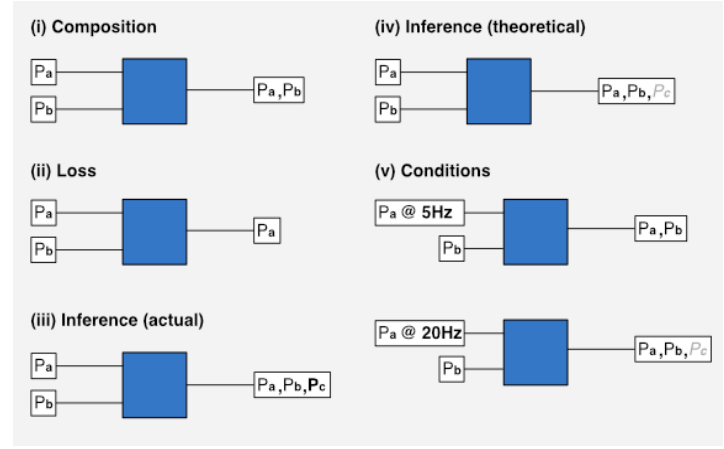
Figure 2. Personal data flows.